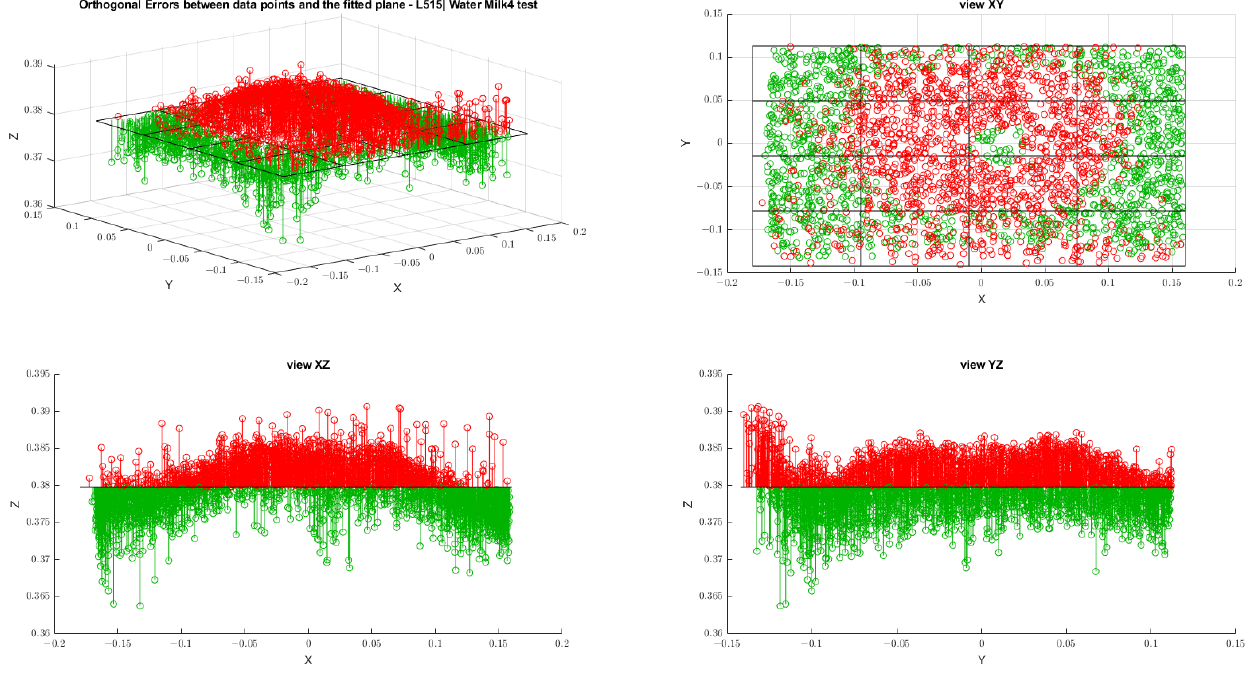
Figure A14. Results of orthogonal errors for the L515 camera referring to the water milk4